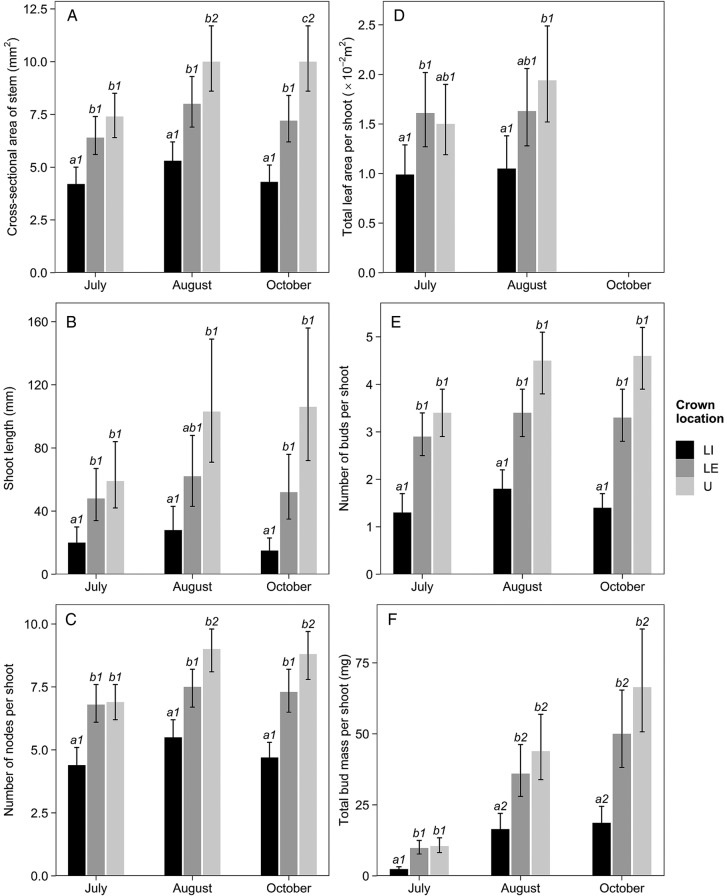
Mean values of shoot characteristics in relation to crown location and sampling month: CSA of stem (A), shoot length (B), number of nodes per shoot (C), total leaf area per shoot (D), number of buds per shoot (E) and total bud mass per shoot (F). Error bars denote 95 % CI. Different letters indicate significant differences among crown locations (within each month), and different numbers indicate significant differences across sampling months (within each location). LI, lower-crown, interior-facing branches; LE, lower-crown, edge-facing branches; U, upper crown.